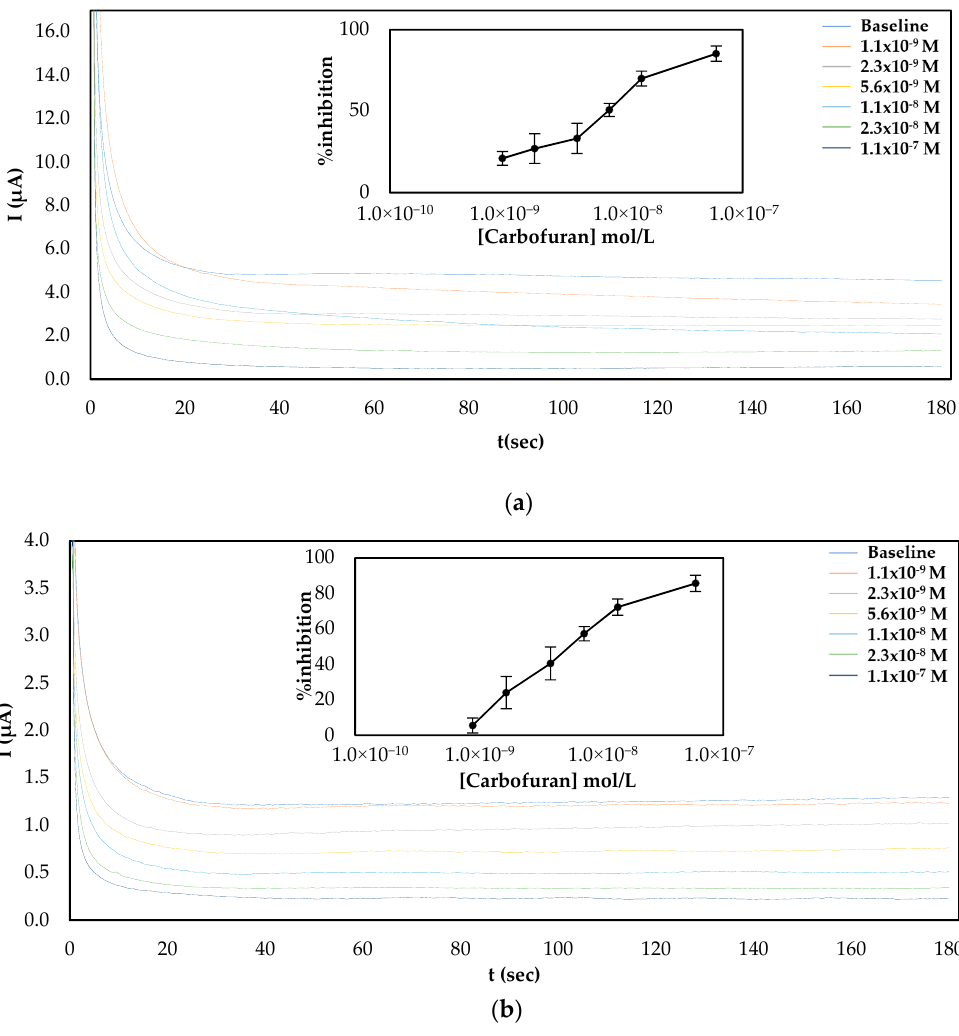
( b ) Figure 3. Optimization of enzyme concentration for sensors fabricated following the ( a ) multistep and ( b ) one-step approaches. Percentage inhibition of the enzyme was calculated following incubation of the biofunctionalized sensor with three different concentrations of carbofuran and recording the current amperometrically at an applied potential of +250 mV. All measurements were taken in